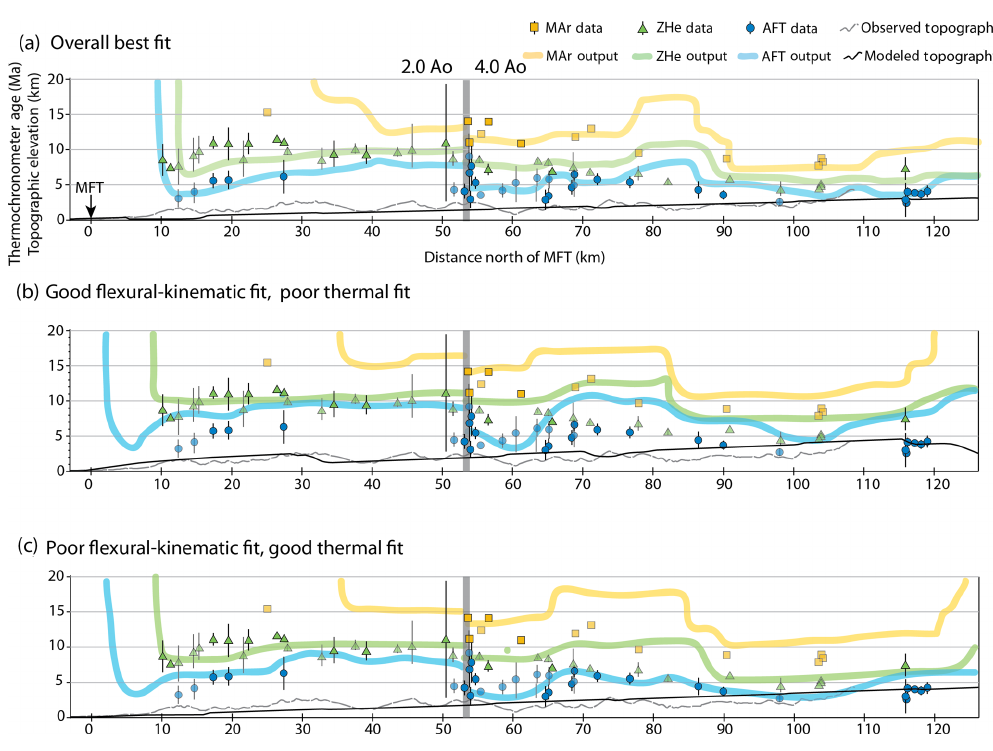
Figure 10. Comparison of predicted MAr (yellow), ZHe (green), and AFT (blue) cooling ages between (a) the best-fitting thermokinematic model combination shown in Fig. 9b, (b) a well-matched flexural–kinematic model that yielded a thermal model with poorly fitting predicted ages, and (c) a poorly matched flexural–kinematic model that produced a thermal model with well-fitting predicted ages. Published data include additional ages from the Kuru Chu line of section 30km west of the Trashigang section (Long et al., 2012) and are indicated by transparent thermochronometer symbols. Predicted ages are presented with combined thermal models using A 0 of 2.0 and 4.0µWm − 3 . Flexural–kinematic models used Split KT and responsive